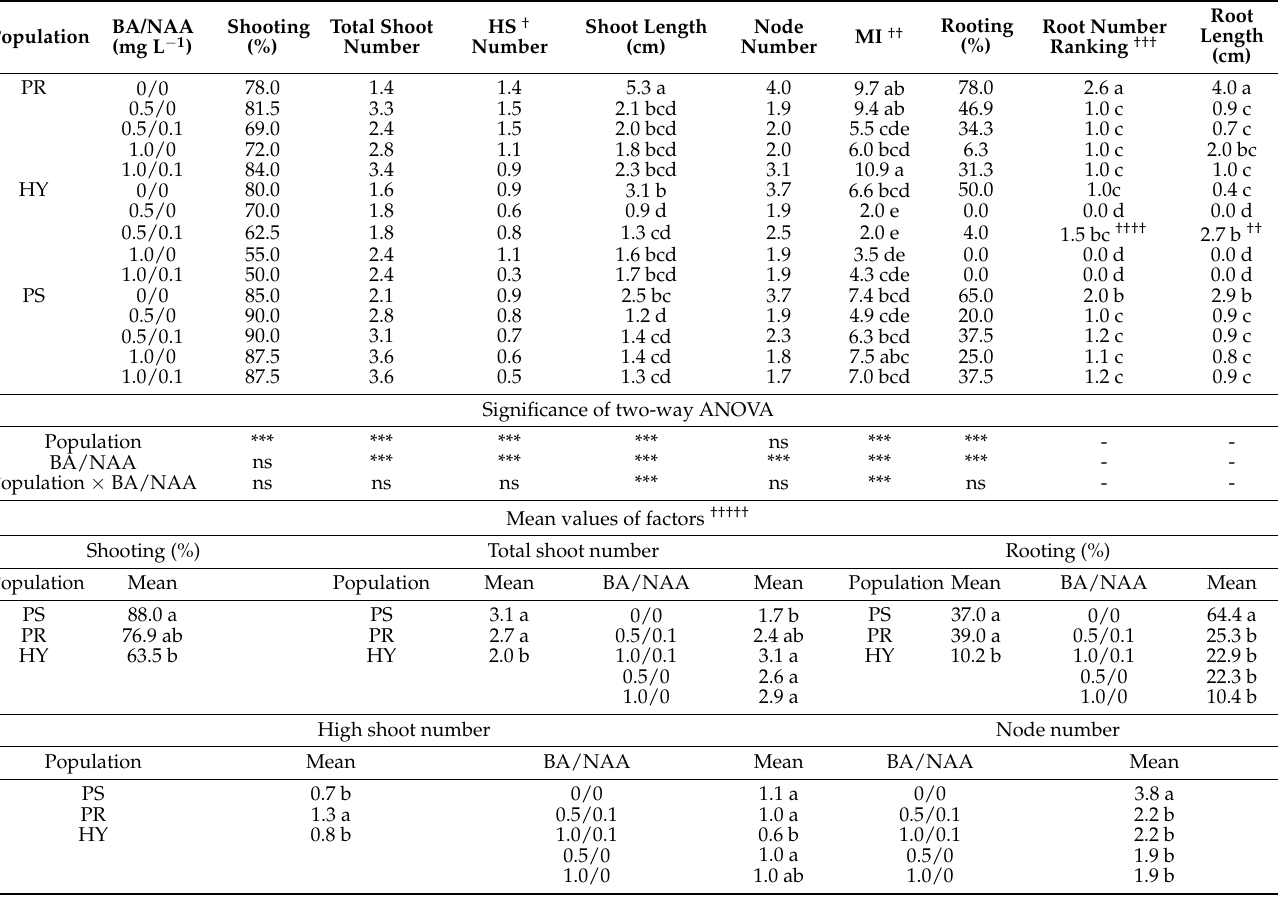
Table 2. Multiplication phase of three populations (Parnitha, Hymettus, Parnassos: PR, HY and PS respectively) : shoot proliferation of C. candidissimum explants excised from shoots produced during the establishment phase, on Murashige and Skoog media without hormone (Hf), or containing 6- benzyladenine (BA) at 0.5 or 1.0 mg L − 1 , with or without 0.1 mg L − 1 1-naphthaleneacetic acid